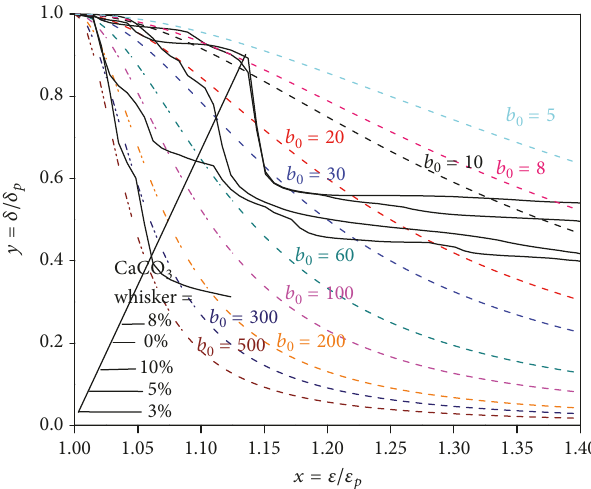
Figure 13: Calculating curve in contrast to the test curve.